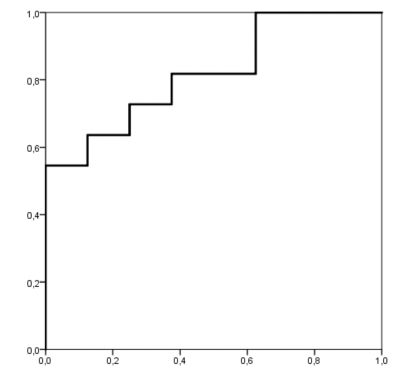
Figure 3. Receiver operating characteristic curve (ROC) analysis for ISBE as a risk factor for lower back pain. The area under the curve is 0.818 (p = 0.021); the coordinates represent a possible cuto ff point in ISBE (the optimal cuto ff point was 65